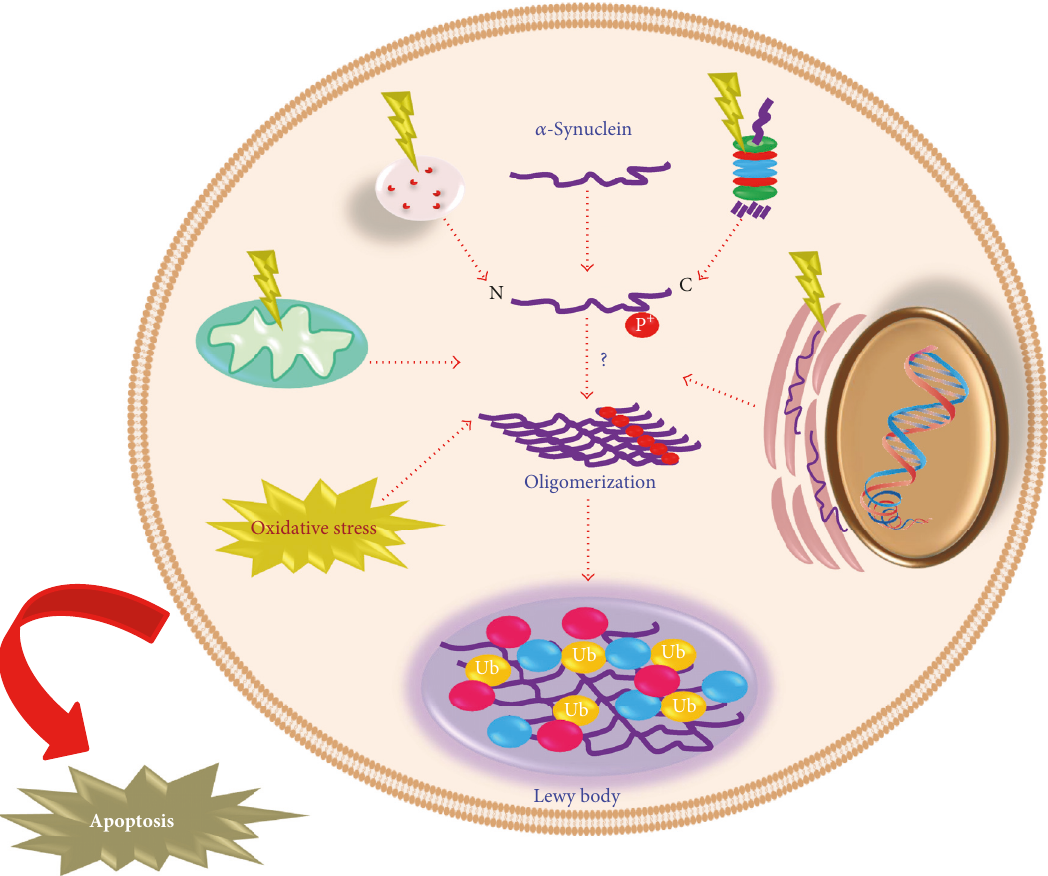
Figure 2: Cell alterations involved in the aggregation process of 𝛼 -synuclein . Damaged or unrequired proteins are regulated by both the proteasomal and lysosomal degradation pathways. UPS disruption leads to activation of the ALS and vice versa, as a compensation mechanism. Both mechanisms are affected in PD, which results in protein accumulation including 𝛼 -synuclein and ubiquitin-bound proteins. Accumulation of unfolded or misfolded proteins into the endoplasmic reticulum activates the unfolded protein response. Mitochondrial dysfunction and oxidative stress are also interrelated and linked to the pathogenesis of PD. All these alterations are associated with the phosphorylation process of 𝛼 -synuclein and increase 𝛼 -synuclein oligomerization, leading to Lewy body formation and subsequent apoptotic cell